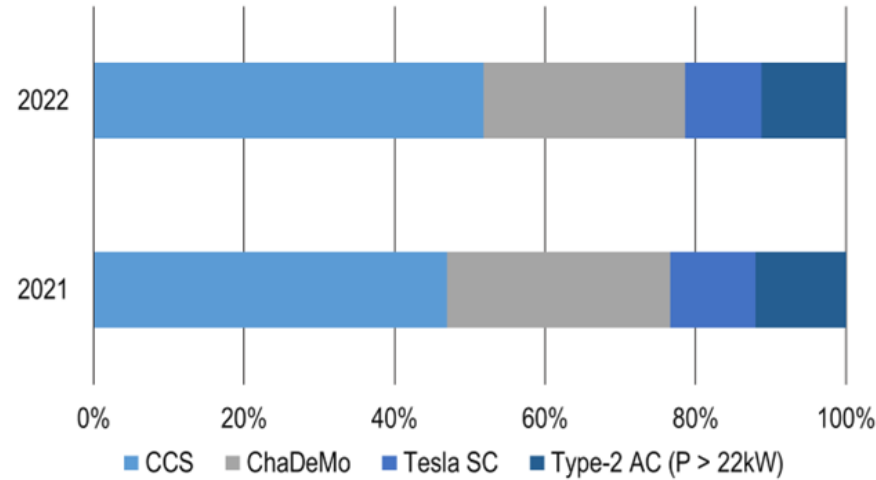
Figure 1. Share of recharging connectors in public charging points in UE.